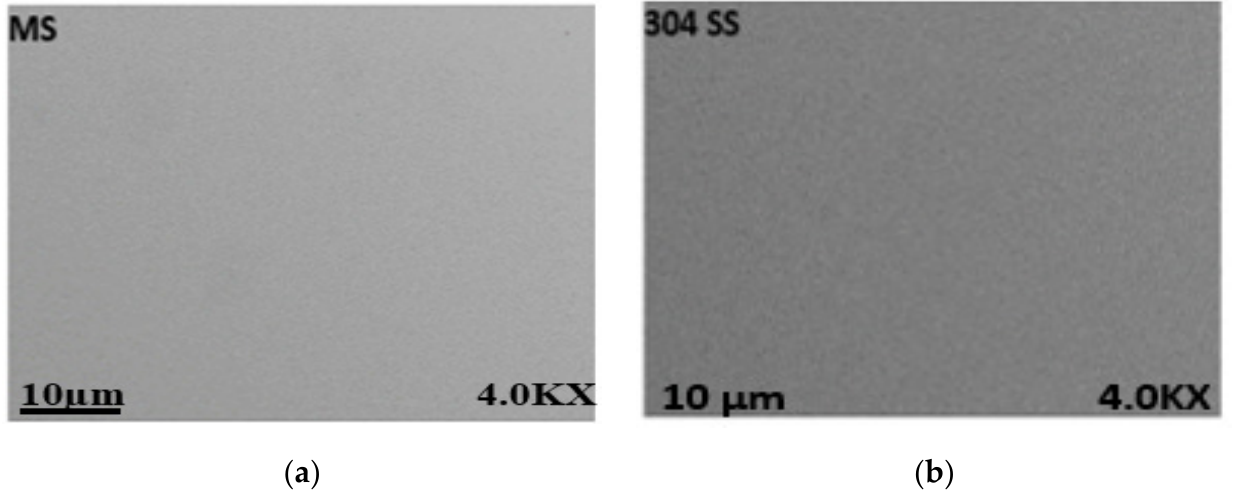
Figure 7. SEM micrographs of ( a ) MS and ( b ) 304 SS electrode surfaces before exposure in NaCl solution.